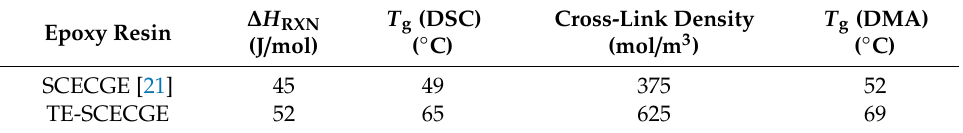
Figure 4. ( a ) First run DSC showing exothermic reaction peaks associated with primary (lower temperature) and secondary epoxy reaction of SCEGE and TE-SCEGE cured with PACM and ( b ) the second DSC runs of the corresponding cured epoxy / amine mixtures showing distinct T g transitions. Table 2. Thermomechanical property comparison of SCECGE and